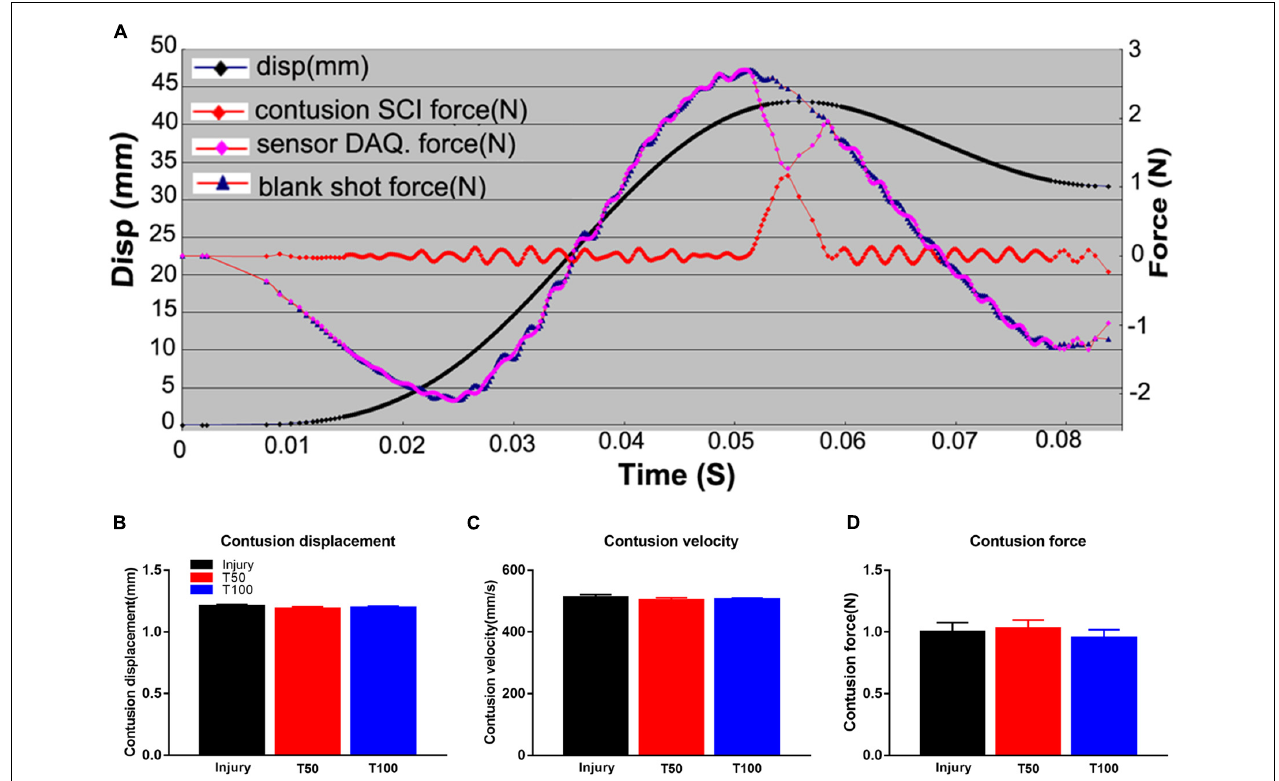
FIGURE 1 | Biomechanical results of hemi-contusion. (A) Curve of displacement and velocity. (B) Contusion displacement comparison of each group. (C) Contusion velocity comparison of each group. (D) Comparison of the contusion forces of each group. There is no significant difference in biomechanical parameters between the